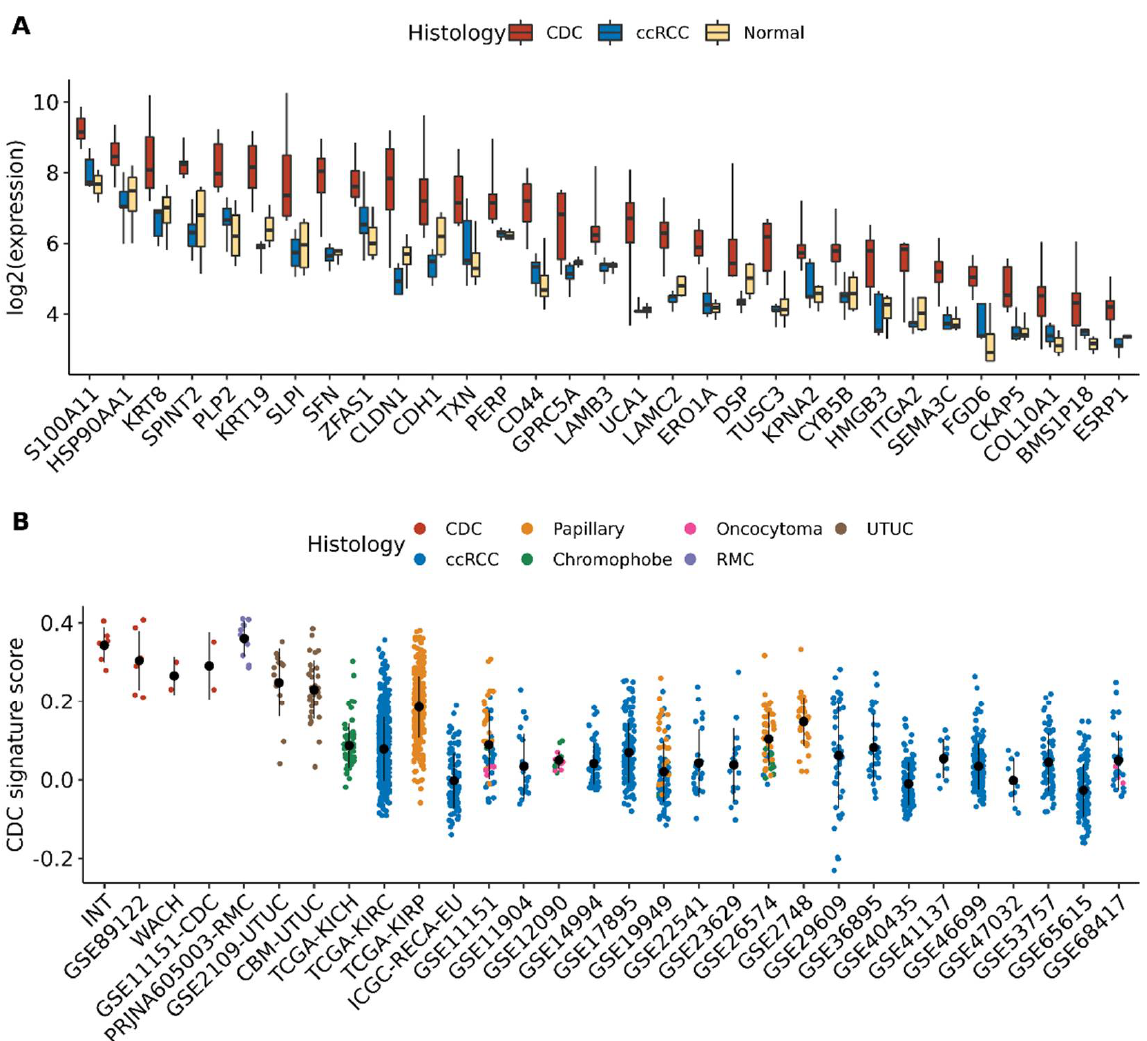
Figure 3. CDC-specific gene signature. ( A ) Boxplot of 31 genes specifically upregulated in CDC compared to normal and clear cell RCC samples in INT dataset; ( B ) distribution of the single-sample enrichment scores of the CDC-specific INT signature in transcriptomic datasets of different kidney cancer histologies. The black dot and line represent the mean and standard deviation of the score in each